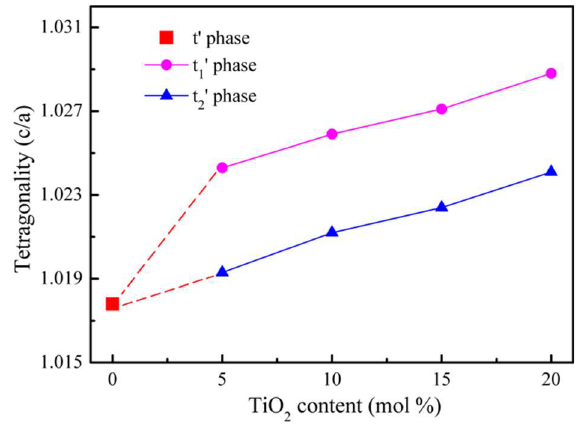
Figure 6. Tetragonality of the t ′ phase in TiO 2 -doped ErSZ.